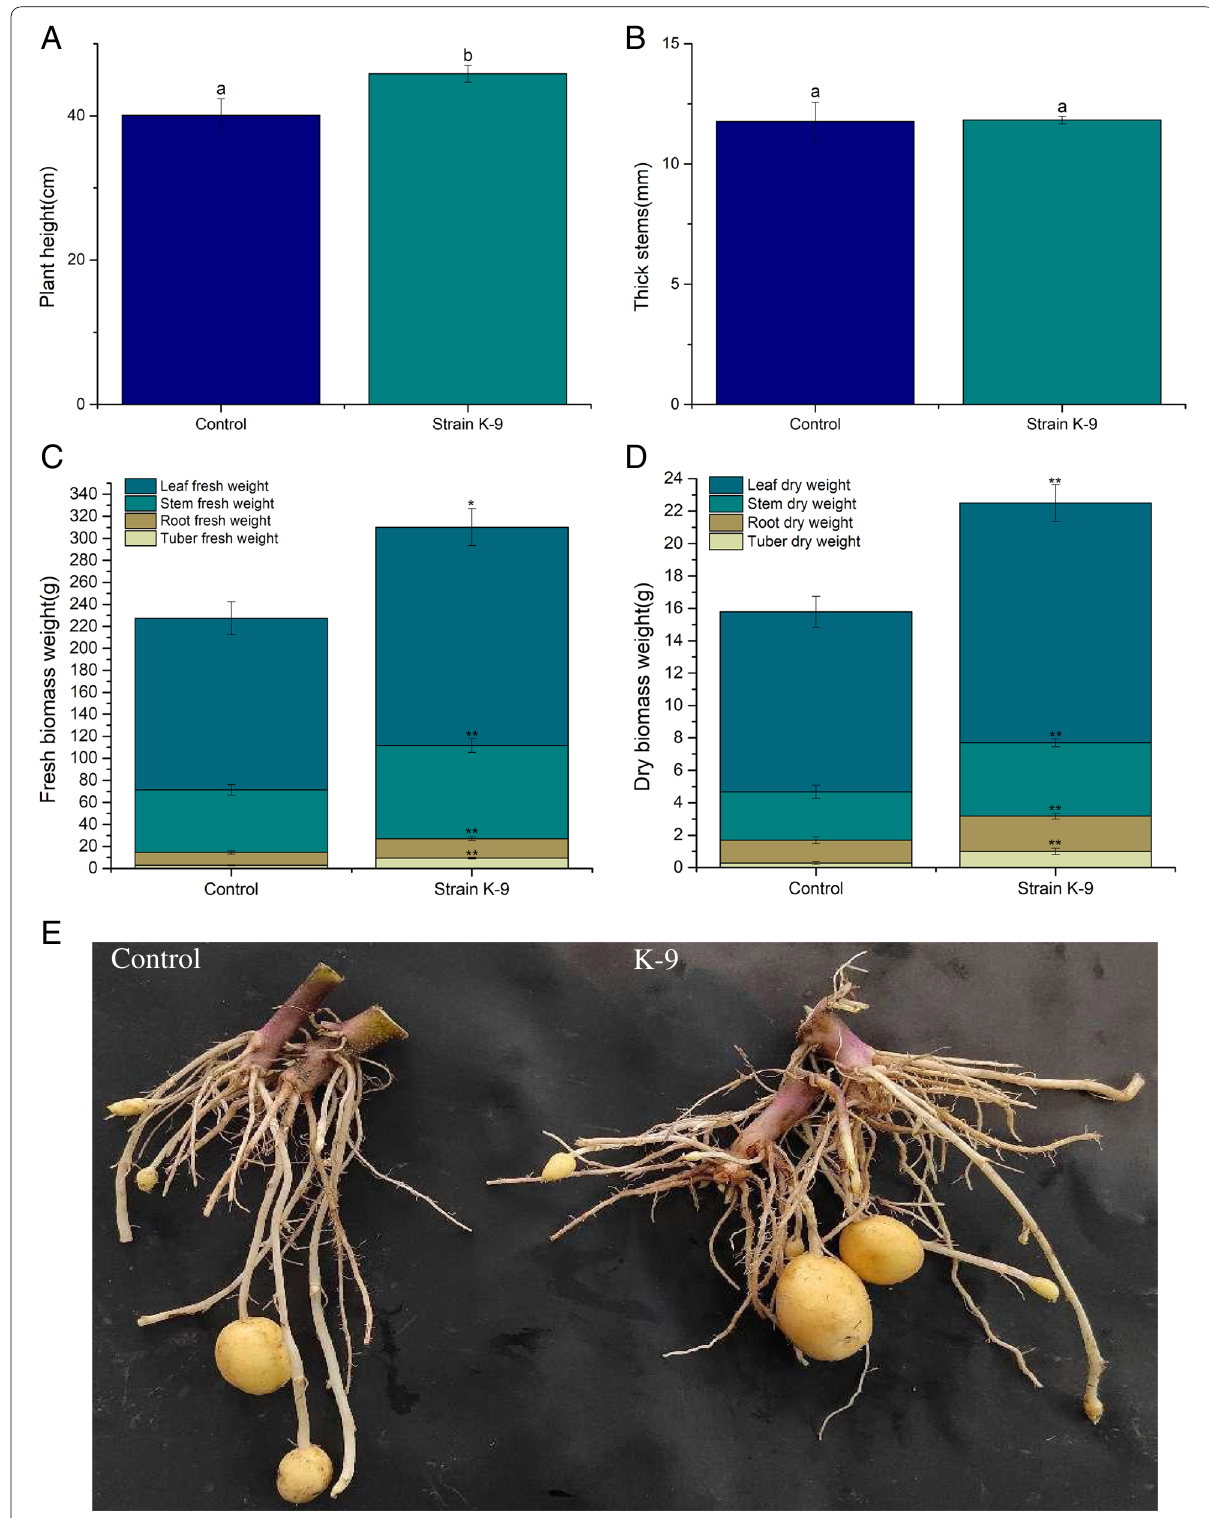
Fig. 6 Effect of strain K-9 on growth promotion of potato tuber during formation. Each treatment had 3 replications. Symbol indicates significant differences according to the Duncan’s multiple range test ( P < 0.05, P < 0.01). A Plant height. B Thick stems. C Fresh biomass weight. D Dry biomass weight. E Root growth phenotype of